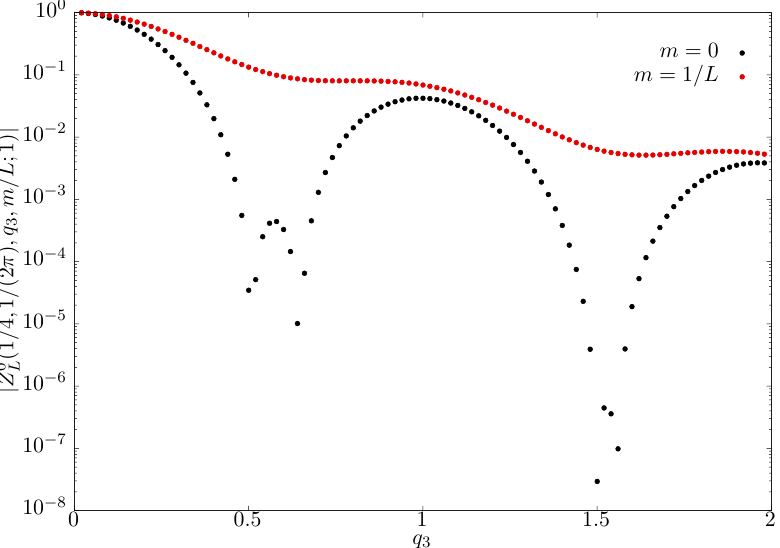
Figure 7. The dependence of the magnitude of the fermion determinant on q 3 . The result at zero and non-zero masses are shown. The determinant at zero mass vanishes are certain values of q 3 , though not for any reasoning from invariance under large gauge transformation as seen in the case of Abelian background field studied in this